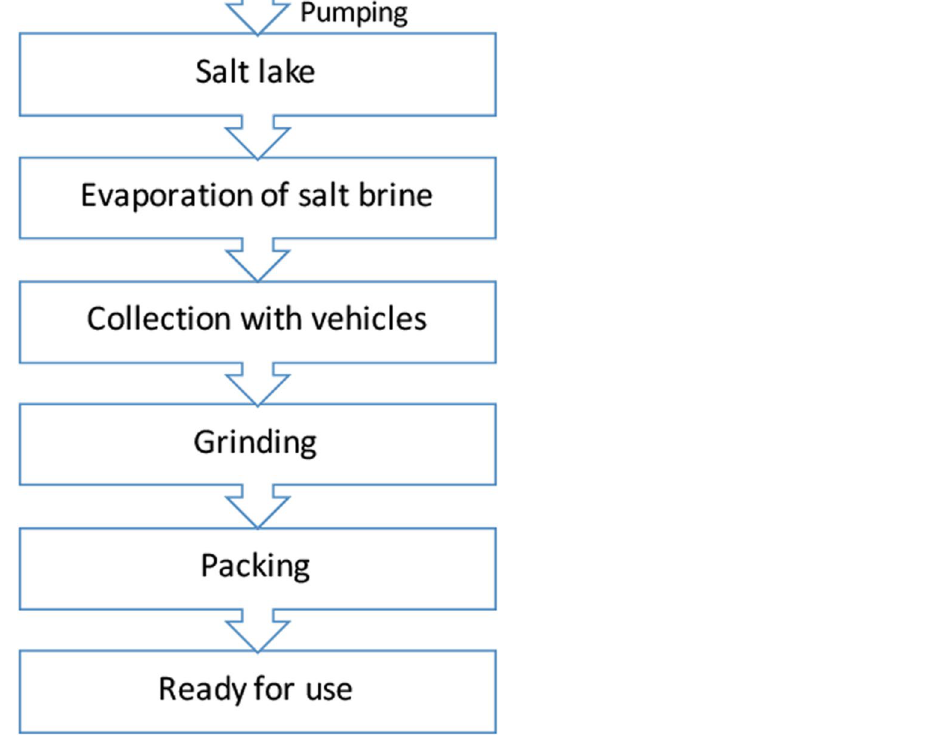
Figure 1. Scheme of the salt manufacturing